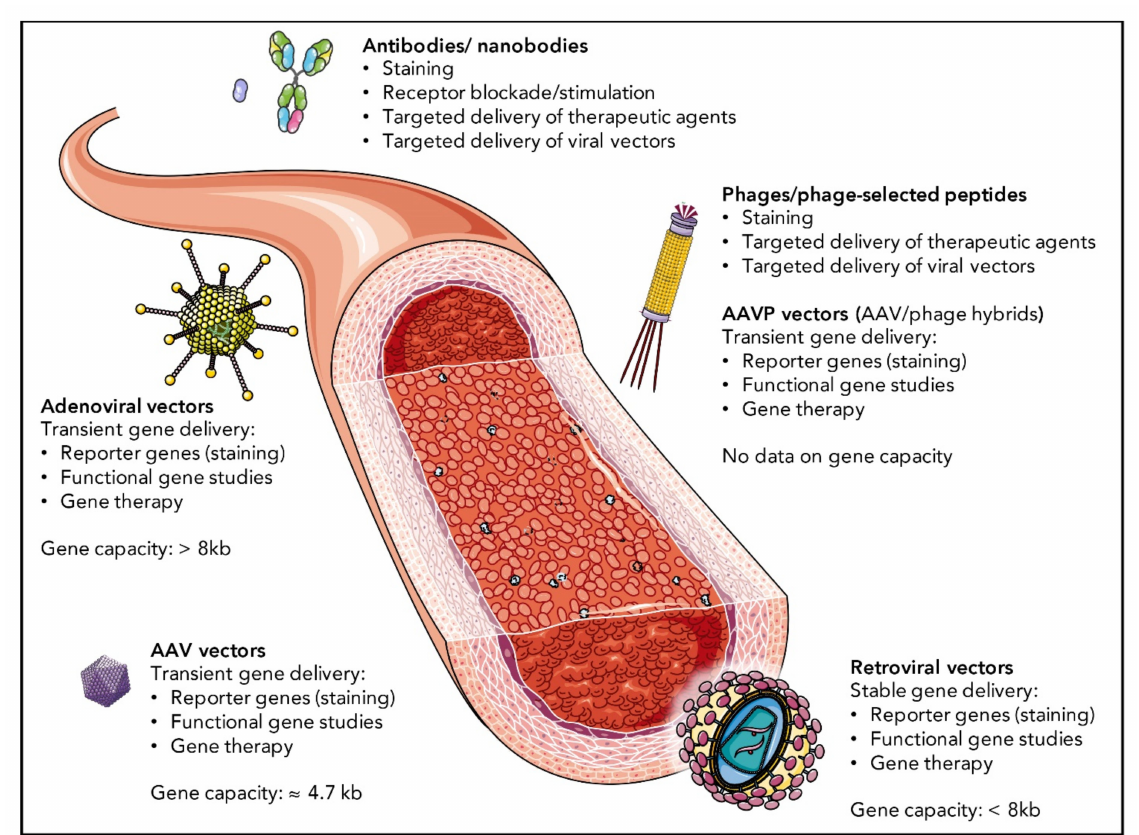
Figure 3. Different approaches of selective EC targeting. Antibodies, nanobodies and phage-selected peptides, as well as different kinds of viral vectors, can be used to specifically target distinct EC populations. Possible applications and limitations of the different targeting approaches are indicated. This figure contains artwork components of Servier Medical